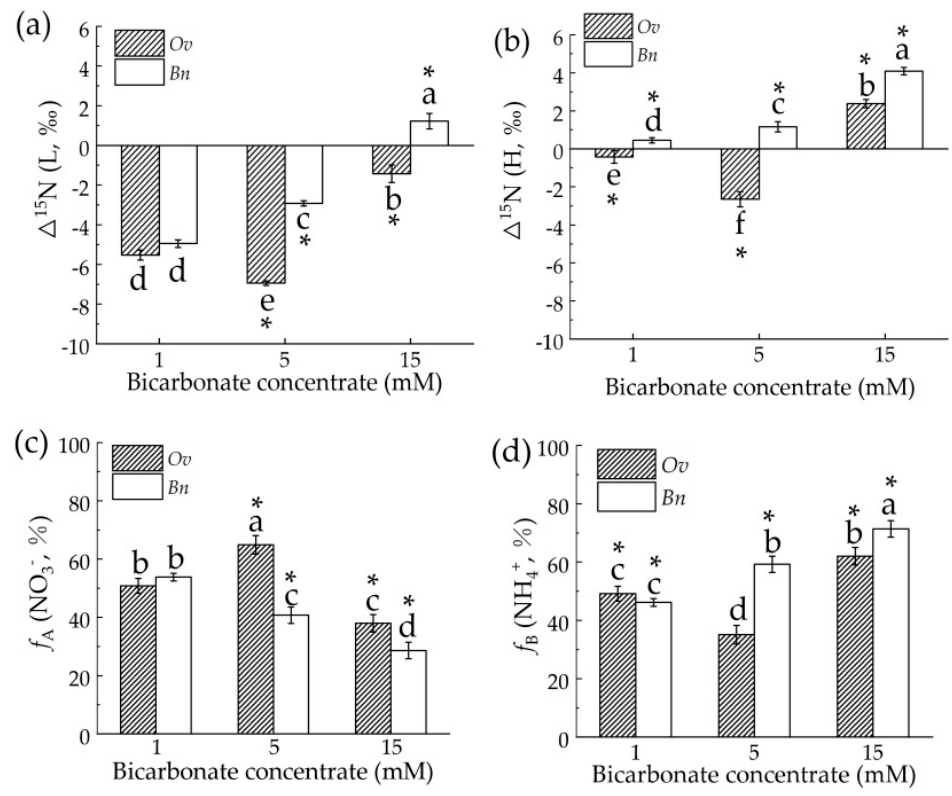
Figure 4. The contributions of nitrate/ammonium of leaves in Ov and Bn at different bicarbonate lev- els. Ov—Orychophragmus violaceus, Bn—Brassica napus , ∆ 15 N—the δ 15 N value, f A —the contribution of nitrate, and f B —the contribution of ammonium. ( a , b )—the δ 15 N value of Ov and Bn , ( c , d )—the contribution of nitrate/ammonium of Ov and Bn . The ratio of nitrate/ammonium within consistent total nitrogen concentration was 14 mM:1 mM under various bicarbonate treatments. Each value represents the mean ± SD ( n = 3), and diverse letters with “*” in each value are significantly different by ANOVA ( p > 0.05).